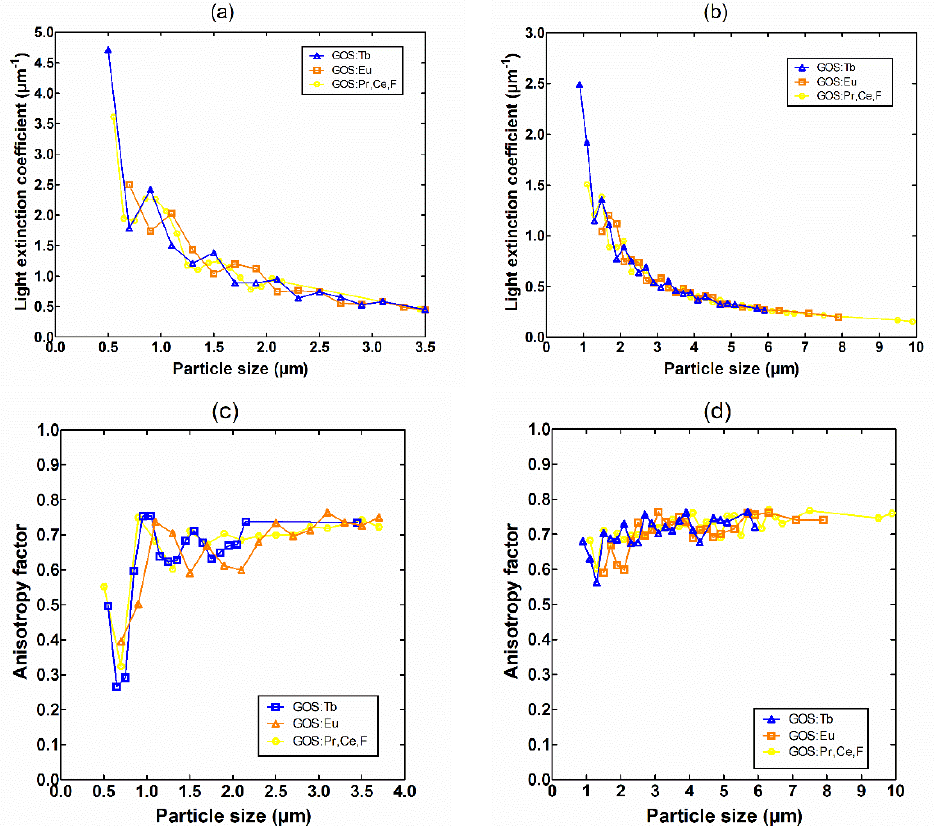
Figure 6. The variation of the ( a , b ) light extinction coefficient and ( c , d ) anisotropy factor, are illus- trated for the GSD distributions provided in Figure 4 of Part 1 of this work. Two comparable sets of GSDs of approximately similar size were considered: (i) 1.232 μ m, 1.769 μ m, and 1.784 μ m ( left side ), and (ii) 2.377 μ m, 3.644 μ m, and 3.677 μ m ( right side ), for Tb, Eu, and Pr,Ce,F, respectively.